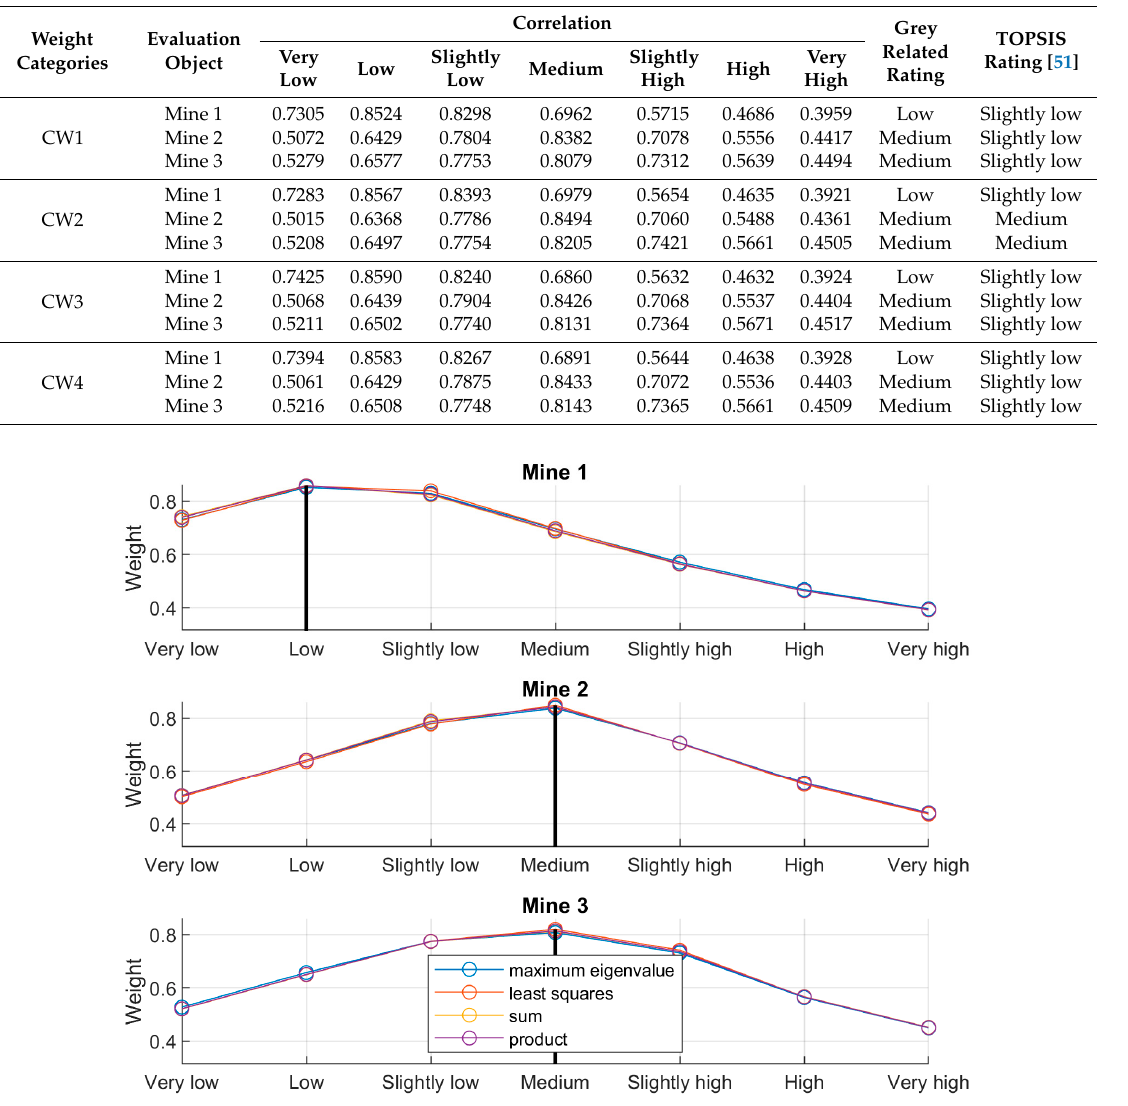
Figure 2. Fuzzy-grey correlation based on the cautious attitude.